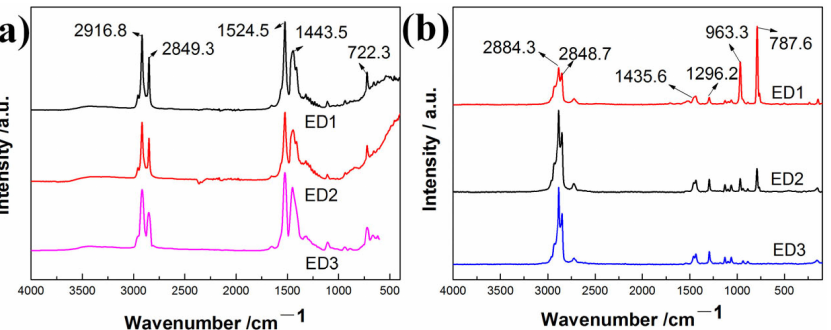
Figure 5. The FTIR and Raman spectra of the surfaces: ( a ) the FTIR results of the samples; ( b ) the Raman spectrum results of the